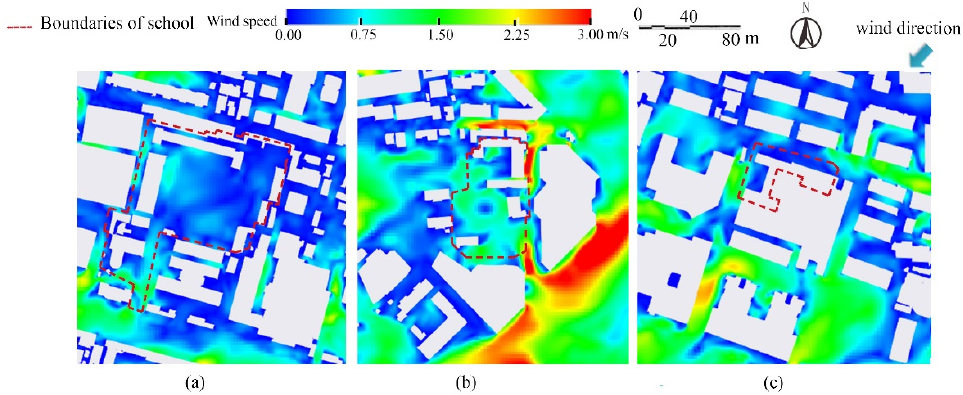
Figure 6. Wind speed distributions at the pedestrian level in three primary schools in summer in the 2010s: ( a ) Changjiang Road Primary School; ( b ) Chibi Road Primary School (Shanxi Road Campus); ( c ) Jianye Road Primary School.